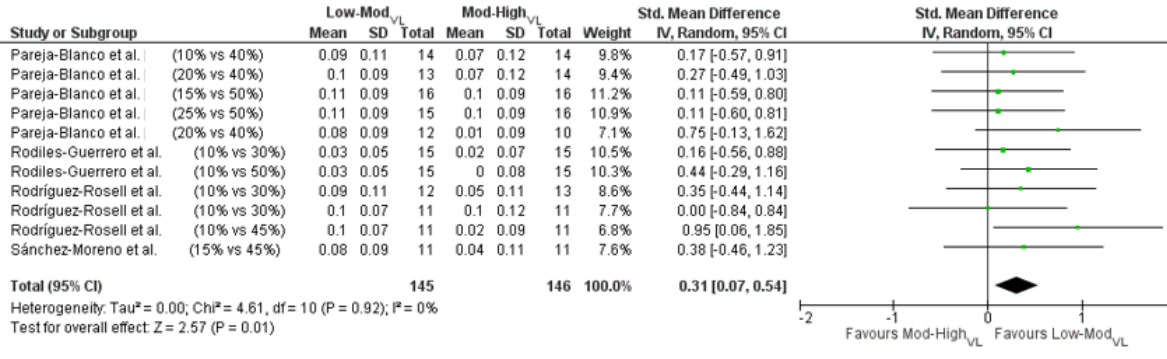
Figure 3. Between-group analysis comparing the effects of Low-Mod VL ( ≤ 25% intra-set VL) and Mod-High VL (>25% intra-set VL) to promote changes at low loads (absolute loads lifted faster than 1.00 m · s − 1 and 0.80 m · s − 1 at pre-training in the squat and bench press exercises, respectively, ≤ 60% 1RM [35,36]). Green squares: ES for each individual comparison; Black diamond: pooled ESs. S á nchez-Moreno et al. [31]; Pareja-Blanco et al. [35,36,38]; Rodiles-Guerrero et al. [39]; Rodr í guez- Rosell et al. [34,40].